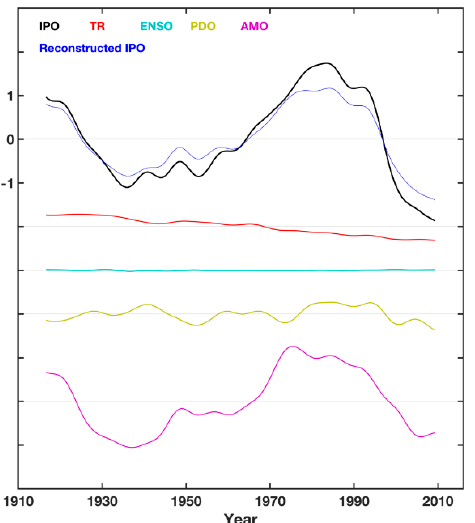
Figure 7. The composition of the IPO. IPO index in black. The composition of the IPO as reconstructed using the sum of its four leading components in blue. The individual component is also shown. It is dominated by the AMO. IPO is here defined as the second Principle Component of 13-year low-pass filtered SST. Reproduced from Chen and Tung [7].